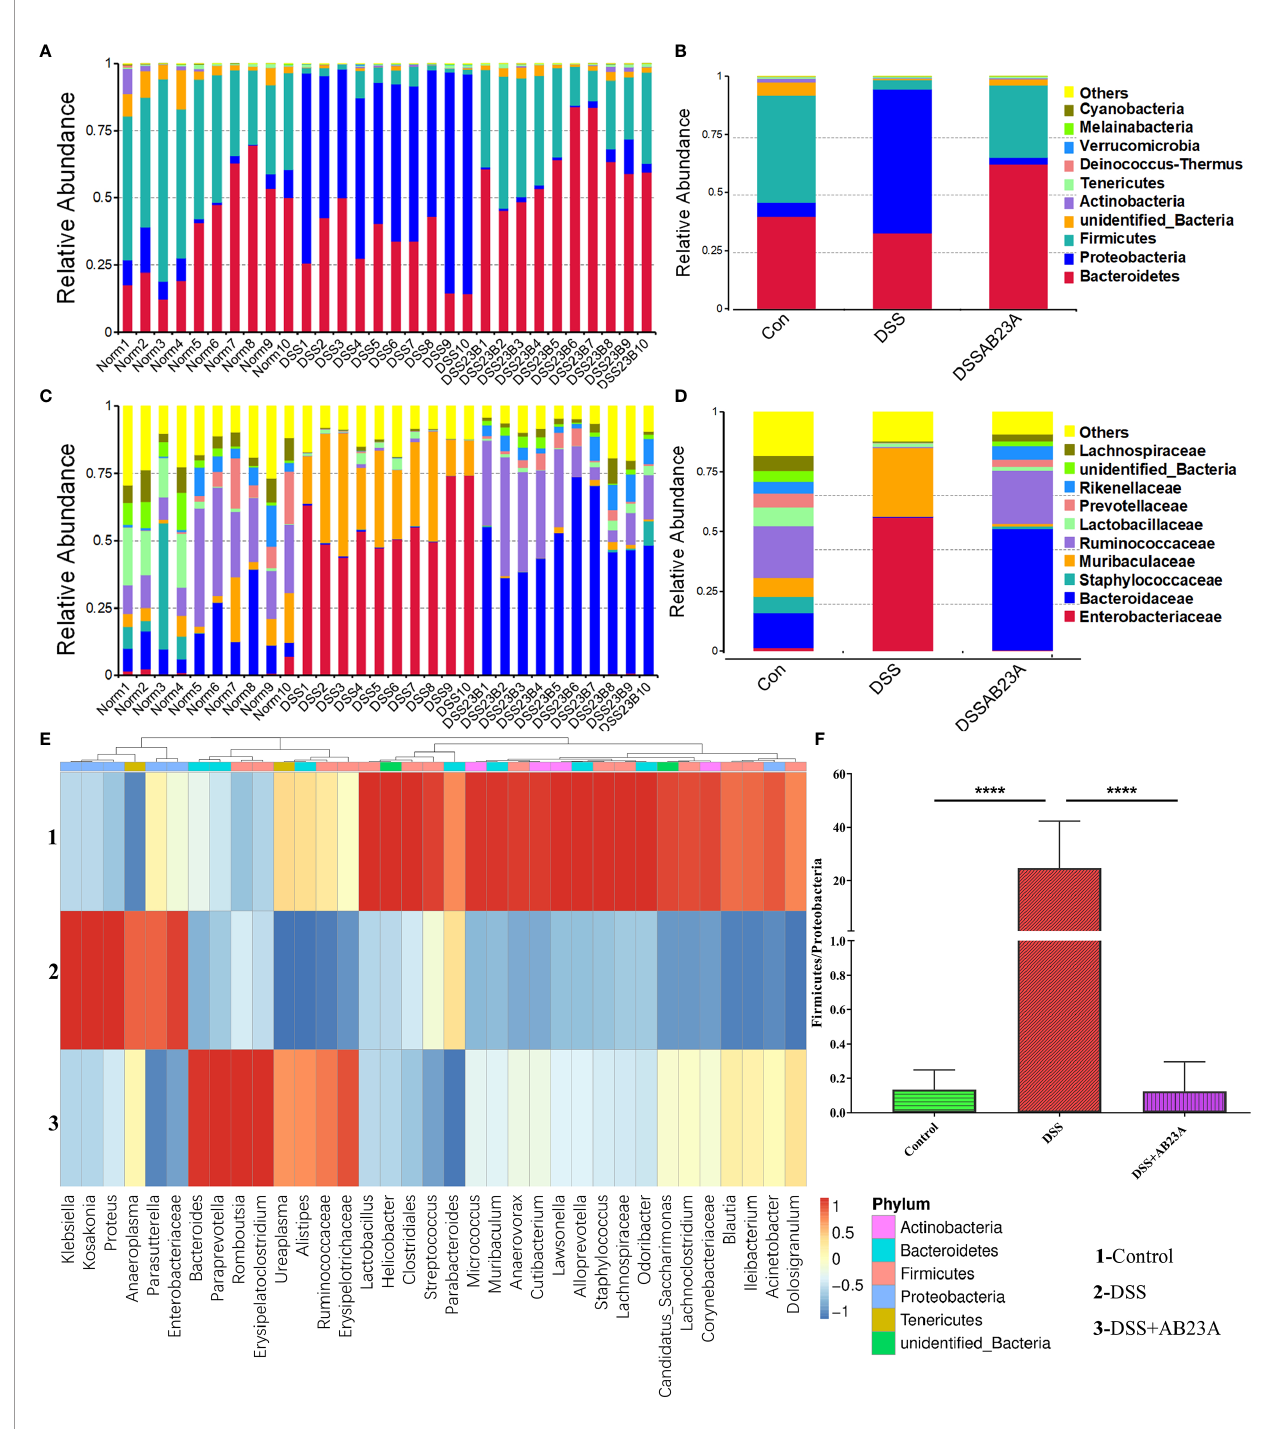
FIGURE 4 | Effect ofAB23A onthe composition of gut microbiota. (A, B) Top 10 species ofgut microbiota at the phylum level. (C, D) Top10 species ofgut microbiota at the familylevel. (E) Heat map of 35 species of gut microbiota at the genus level. (F) Ratio of Proteobacteria to Firmicutes (vs. DSS: ****P <